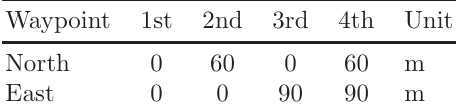
Table 4: Table of waypoints in the